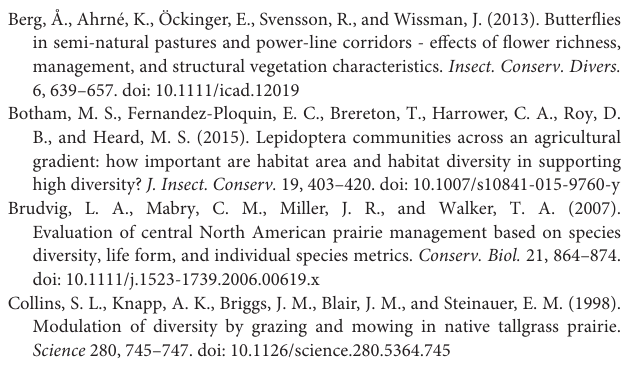
Figure S1 | Example site map with transects and vegetation plots distributed proportionally in each prairie type. Mesic prairie is shown in white (5.9 ha) and wet prairie is shown in gray (1.53 ha). Total site area is 7.43 ha. Transects run perpendicular to elevation gradients and vegetation plots (not to scale) are oriented perpendicular to the transects they are on. The three transects in mesic prairie are M1 (103m; 6 plots), M2 (236m; 7 plots) and M3 (170m; 6 plots). Wet transects are W1 (53m; 2 plots) and W2 (64m; 2 plots). Monarchs were surveyed on 400 meters of randomly selected vegetation transects in proportion to wet and mesic prairie types: all of transect M2 and 84m of M3 were surveyed to equal 320m in mesic prairie ( ∼ 80%) and all of W1 and 27m of W2 were surveyed to equal 80m in wet prairie ( ∼ 20%). Table S1 | Index of study sites including forb, Asclepias, and monarch survey data. Table S2 | Full model results for monarch abundance at burned and grazed sites, burned-only sites, and grazed-only